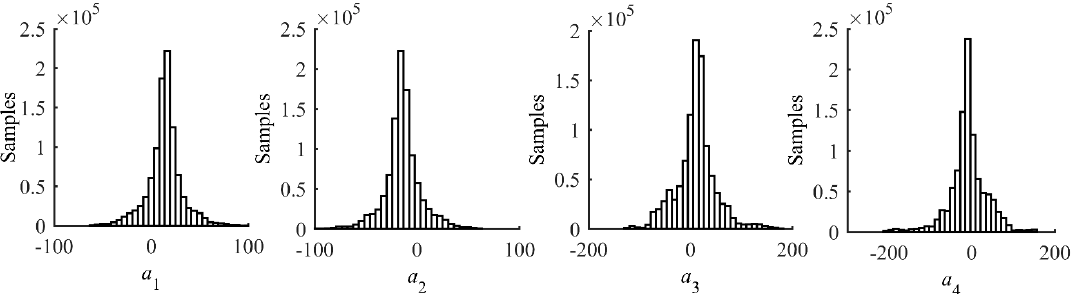
Figure 12. Histograms of the updated model parameters.